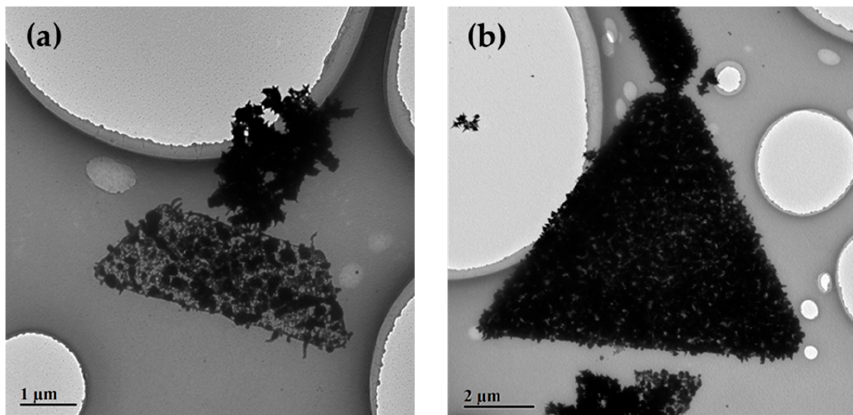
Figure 6. Complex nanostructures of Ag@AuCu trigonal nanoplates with a moderate concentration of AgNO 3 (200 µ L). ( a ) A cluster of Ag@AuCu nanostructures on a half trigonal nanoplate. ( b ) A nanowire of Ag@AuCu nanostructures connected to a trigonal nanoplate.